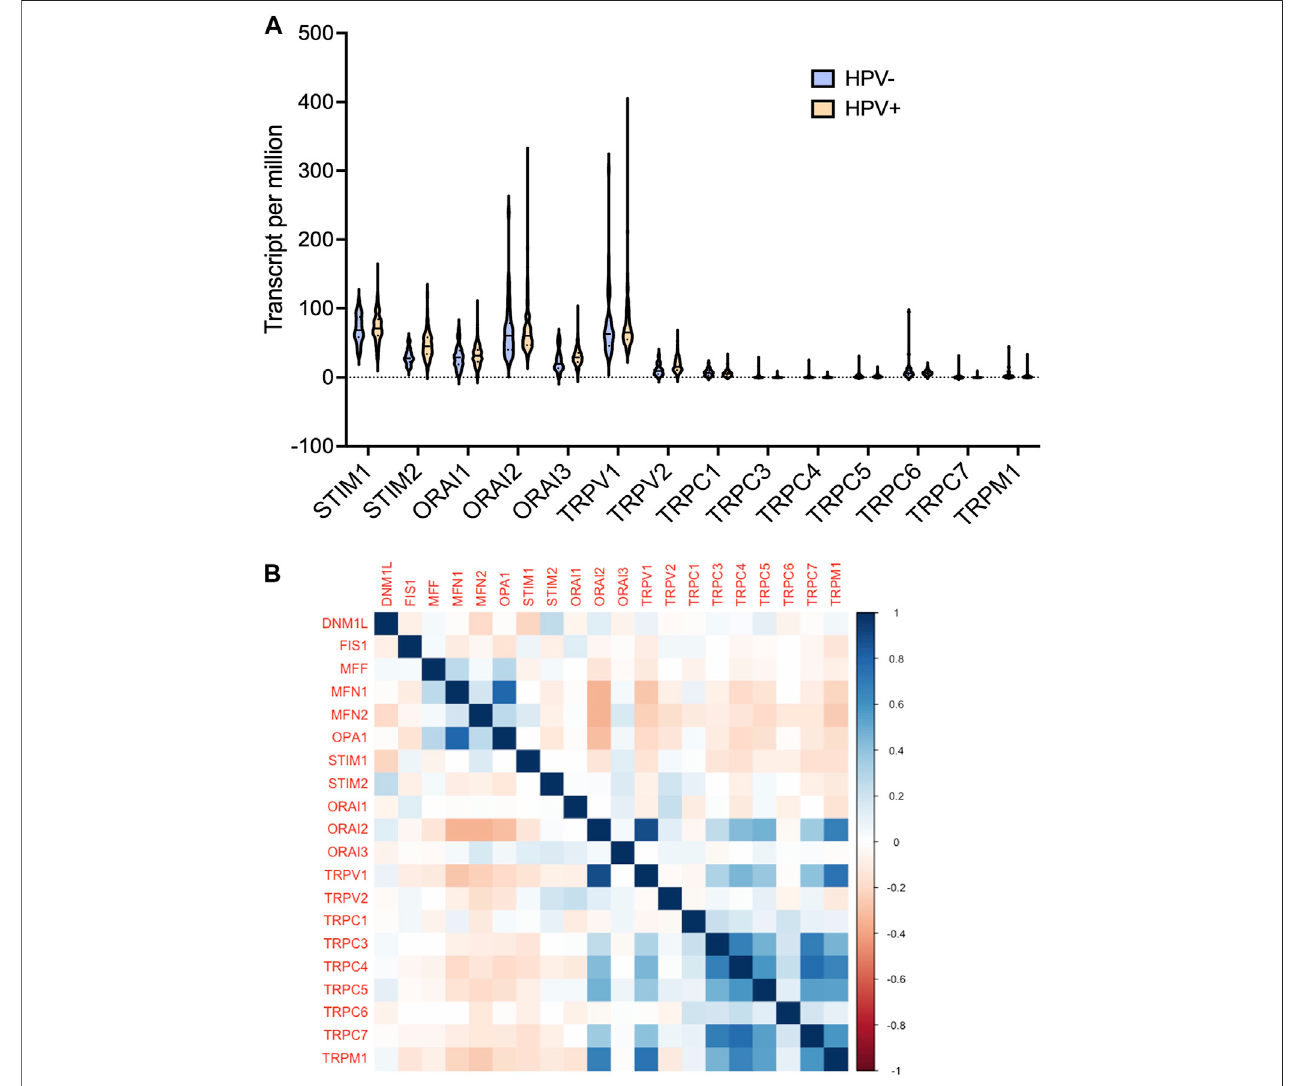
FIGURE11| mRNA expression levelsofSOCswerecorrelatedwith theexpression ofMDGs inboth HPV positiveand negative HNSCs. Theexpression datafrom GSE17898 was downloaded from GEO datasets consisting total of 323 samples (A) The levels of SOCs are plotted using Graphpad prism software and (B) correlation analysis was performed and plotted using Corr Plot package for R statistical environment. The gradation on the right side denote the correlation coef fi cient.